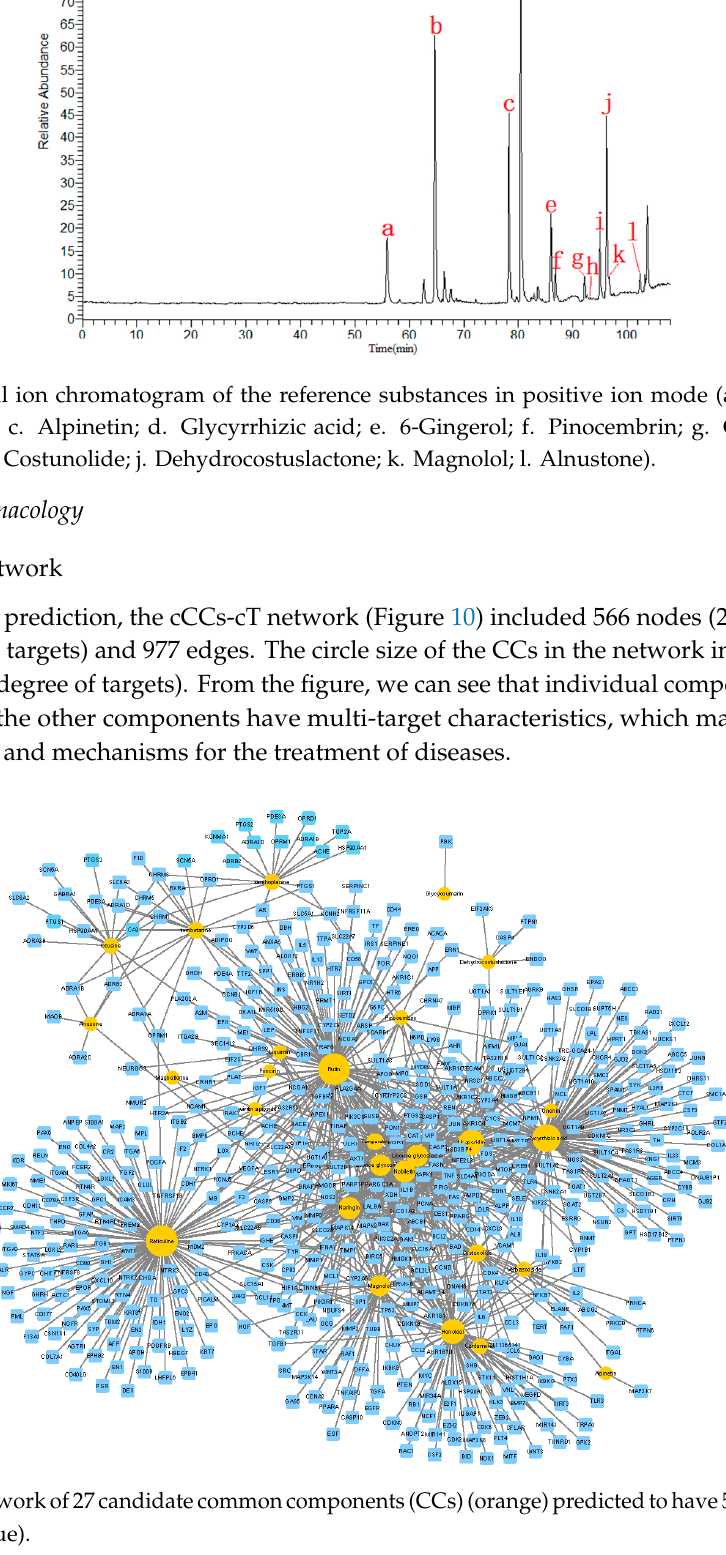
Figure 10. Network of 27 candidate common components (CCs) (orange) predicted to have 539 targets (sky candidate targets (sky blue).